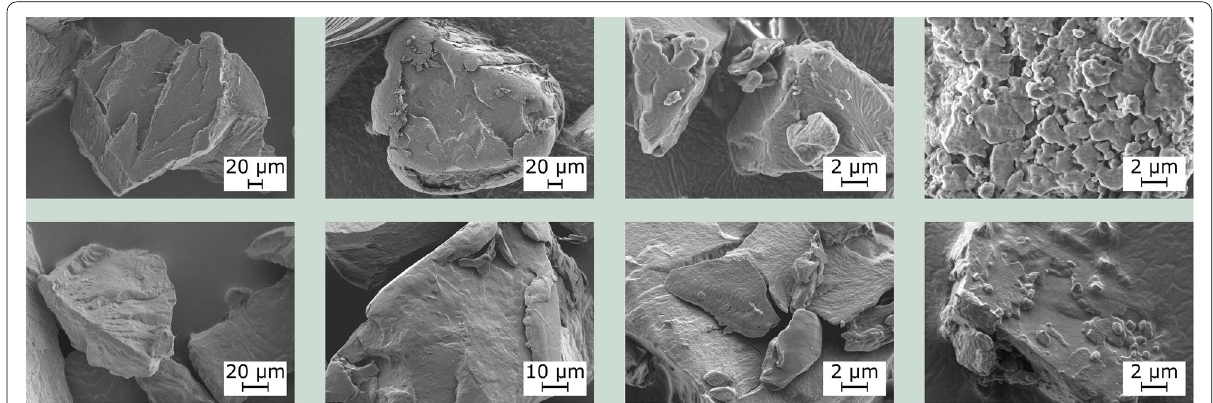
Fig. 5 A - D SEM images of PP with stabilizer and E - H without stabilizer. A & E Virgin particles, reference material, B & F smoothed particles after 200 h, C & G particle fragments after 800 h and D & H particle surfaces after 2000 h. Smaller particles in the nanometer-range are visible on the